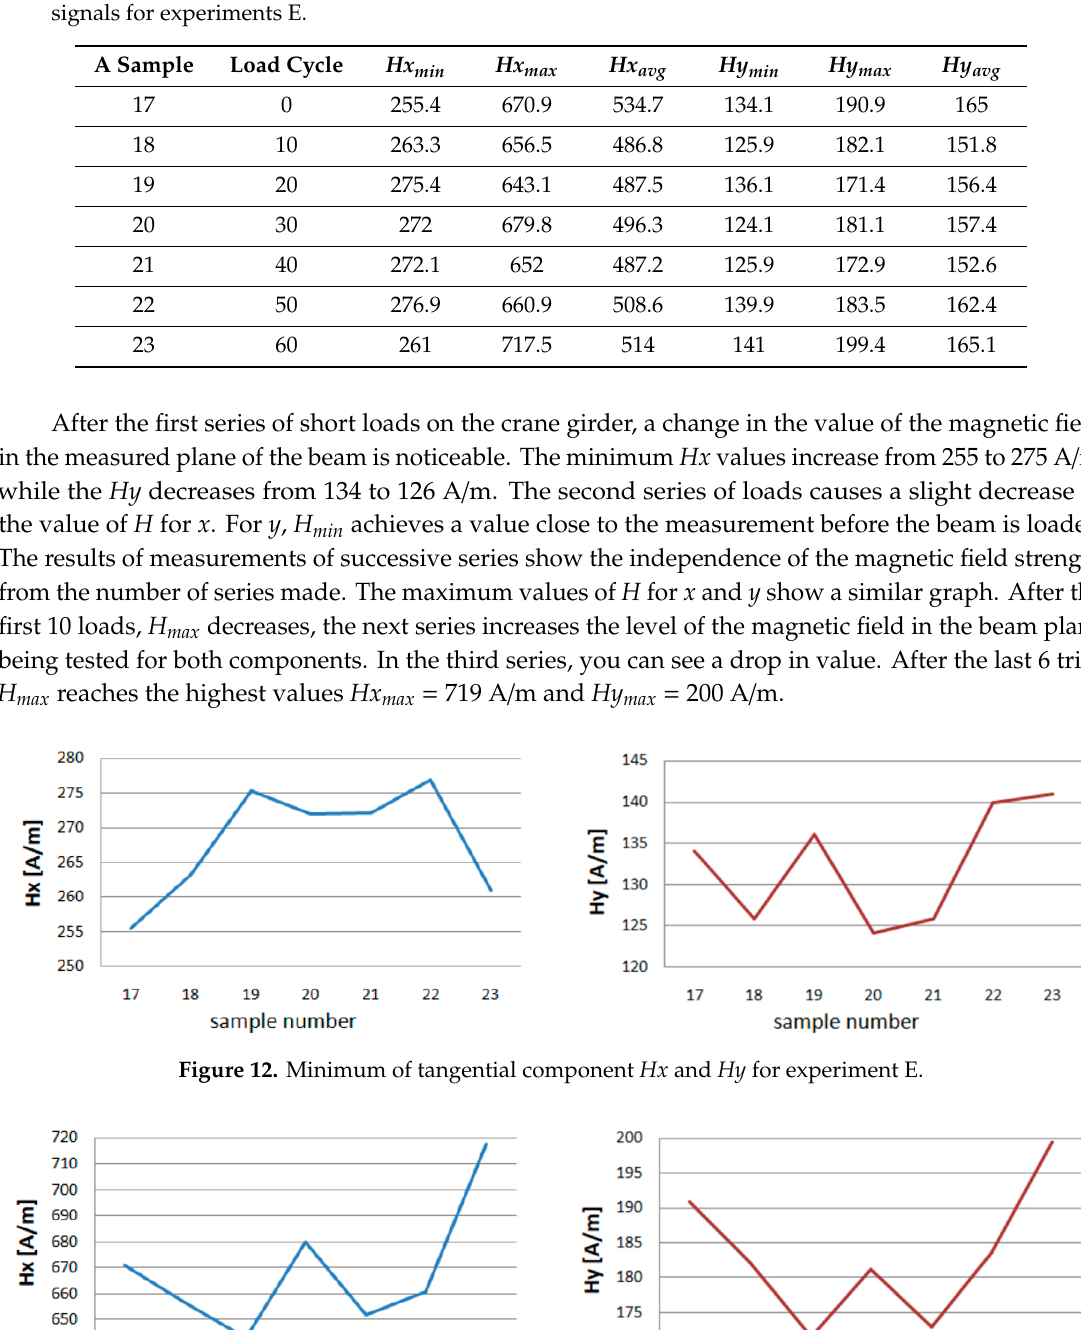
Figure 14. Graphs of tangential Hx and normal Hy component of the magnetic field, for sample 17. Figure 15. Graphs of tangential Hx and normal Hy component of the magnetic field, for sample 23. The curve illustrating the x component before and after the experiment involving a similar course, when the curve illustrating the component Hy contains a significantly different character. The minimum Hx reaches in the range of 350–400 mm while the maximum in the range 550–600 mm. In the case of the y component, it is impossible to clearly determine the fixed place where it reaches its maximum and minimum. 4. Conclusions The paper addresses the problem of the crane structure inspection by applying the MMM method. The crane girder was the subject of inspections of the effect of load on changes in tangential and normal components of the magnetic field using MMM. When analyzing the results of measurement experiments, it can be seen that with each load change, the magnetic field strength changes. These